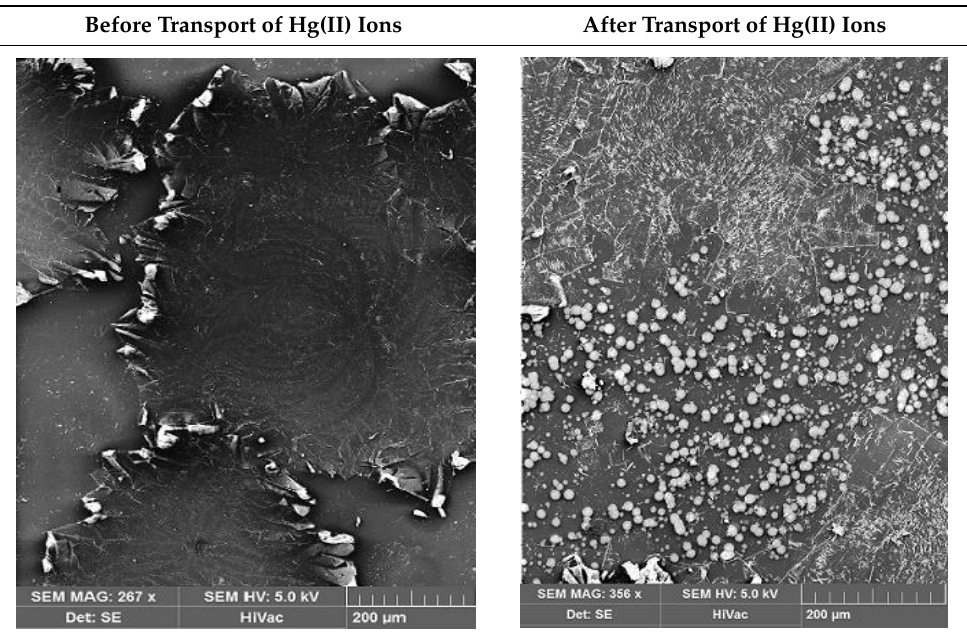
Table 1. SEM images before and after the transport of Hg(II) ions across PIM containing KP. Source phase: 1.0 × 10 −6 M Hg(II); membrane: 19 wt.% of CTA, 4 wt.% of KP, 77 wt.% of o -NPOE; receiving phase: 0.1 M NaCl.